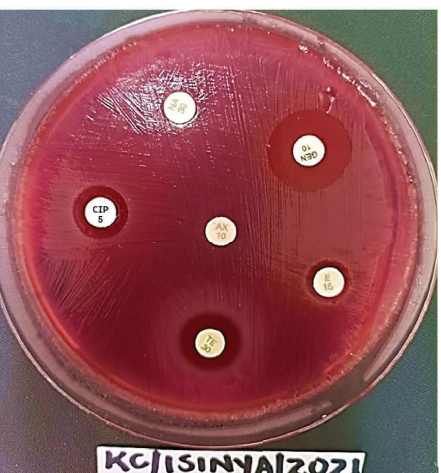
Figure 2: A representative photograph of antibiotic susceptibility profle of thermophilic Campylobacter isolate on Mueller–Hinton blood agar (MHBA) culture plate.